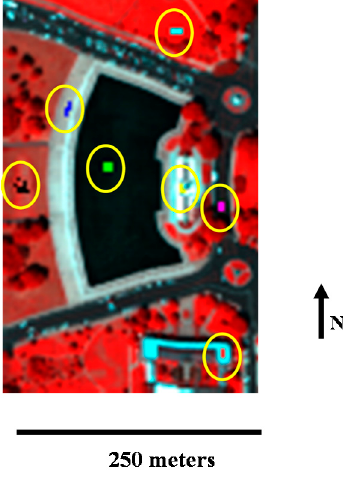
Figure 8. The Washington DC sub-scene data set.